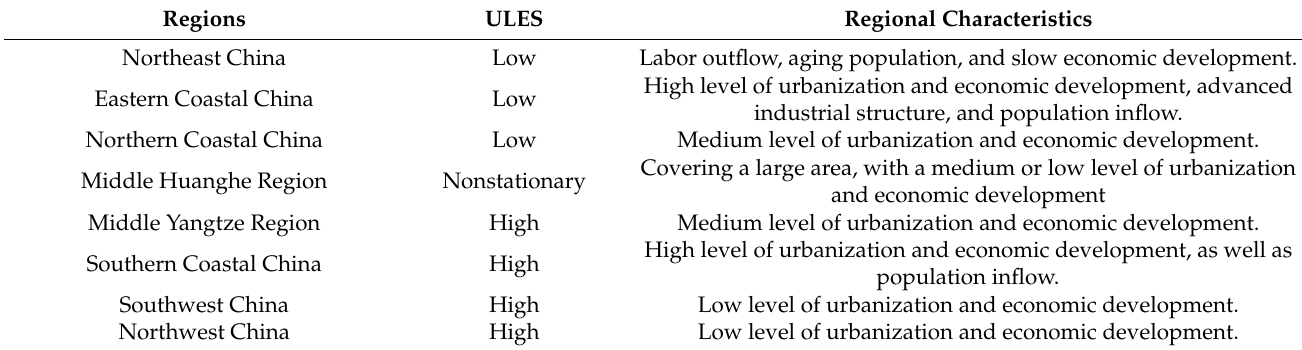
Table 2. ULES and its regional characteristics.